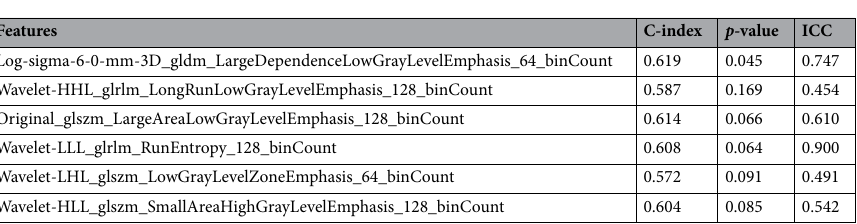
Table 1. The characteristics of selected features for model building. The univariate C-index, p -value, and ICC were tabulated. Feature names indicate the feature, the bin count (if applicable), and the image used to compute